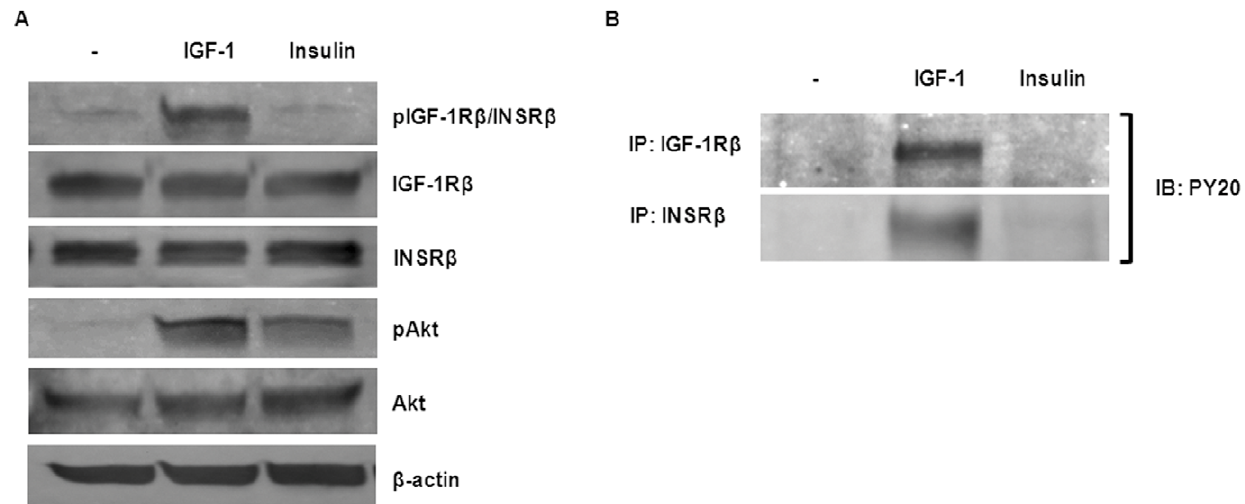
Figure 1. IGF-1 induces the canonical IGF-1R/Akt signaling pathway. (A) Akt phosphorylation induced by IGF-1 and insulin. hTCEpi cells were starved for 24 h in KBM-2 culture medium and then stimulated with IGF-1 (100 ng/ml) or insulin (100 ng/ml) for 15 min. Whole cell lysates were immunoblotted (IB) with anti-phospho-IGF-1R b , anti-IGF-1R b , anti-INSR b , anti-phospho-Akt, anti-Akt, or anti- b -actin (loading control) as indicated. (B) IGF-1-induced IGF-1R phosphorylation. Protein lysates obtained as above were immunoprecipitated (IP) with anti-IGF-1R b (CST # 3027) or anti-INSR b (C-19) and phosphorylation of both receptors was detected on immunoblots with anti-PY20. Blots are representative of at least two repeated experiments.